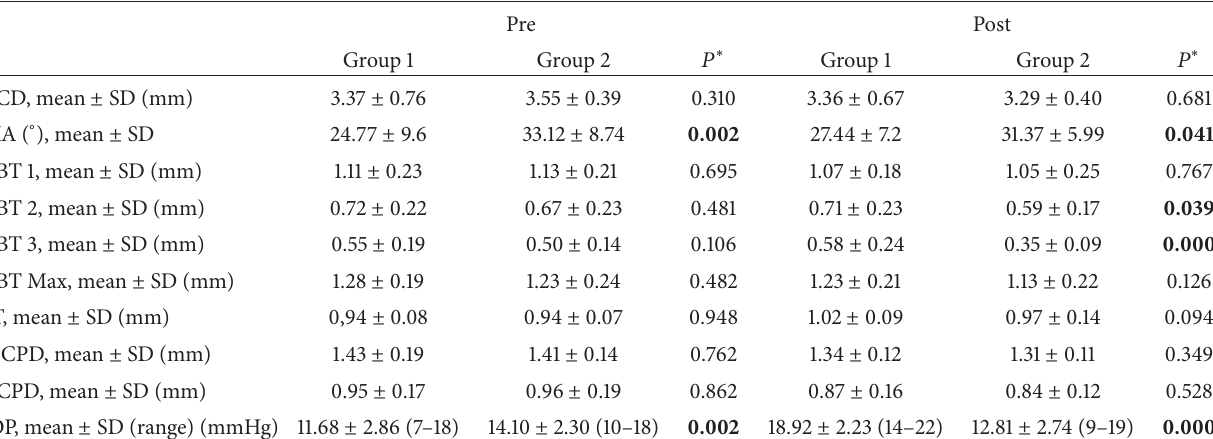
Table 4: Comparison of the between-groups preoperative and postoperative parameters of the anterior segment and the angle of the temporal quadrant and IOP.